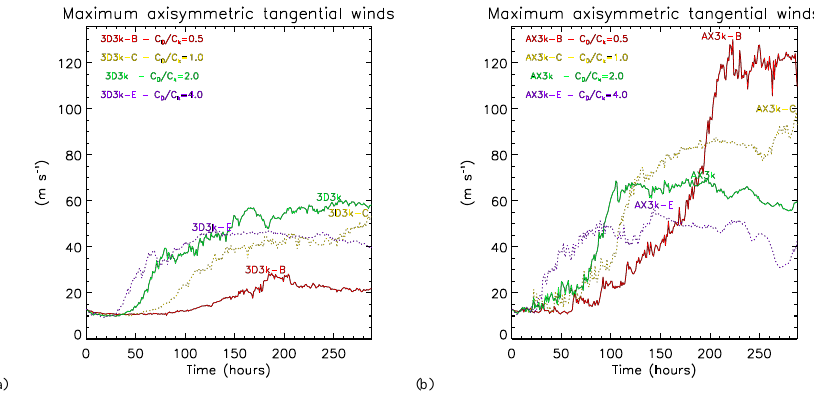
Fig. 21. Maximum tangential velocity as a function of time for a series of experiments in the CM1 model with increasing surface drag coefficient C D : a) four 3D simulations (3D3k-B, solid red; 3D3k-C, dotted yellow; 3D3k, solid green; 3D3k-E, dotted-blue,), with 3D3k being the control; and (b) four AX simulations (Ax3k-B, solid red; Ax3k-C, dotted yellow; Ax3k, solid green; Ax3k-E, dotted blue), with Ax3k being the control. Experiments B have C D =0 . 25 × control C D . Similarly, experiments (C, E) have C D =(0 . 5 , 2 . 0) × control C D , respectively. See text fordetails.